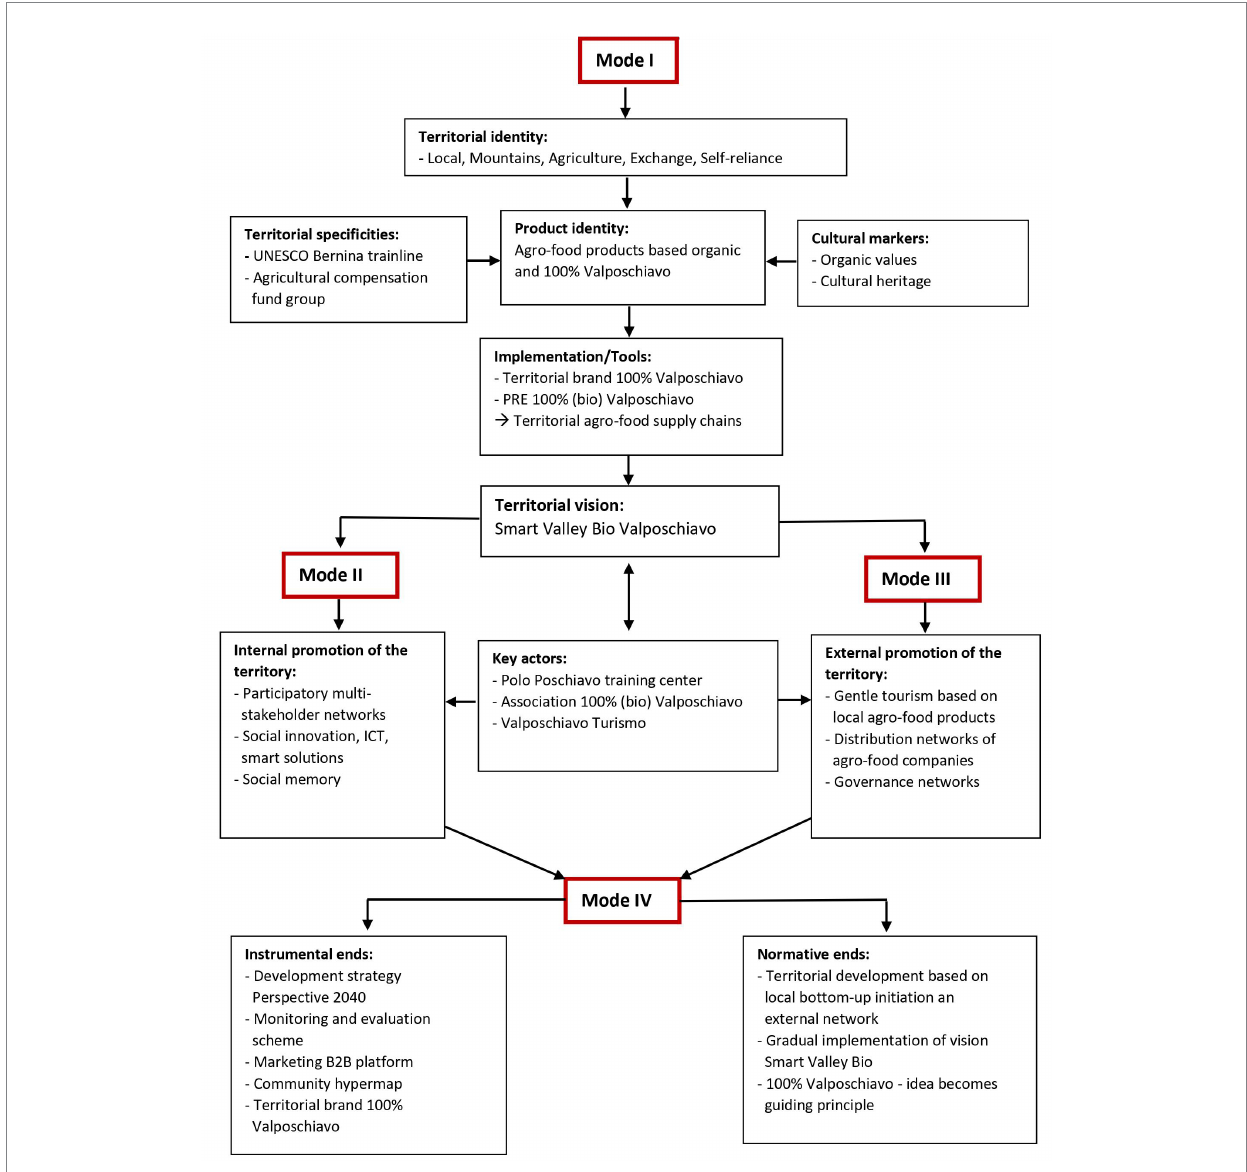
FIGURE 6 Neo-endogenous development in Valposchiavo based on Ray (2001) and Stotten et al. (2018), created by the